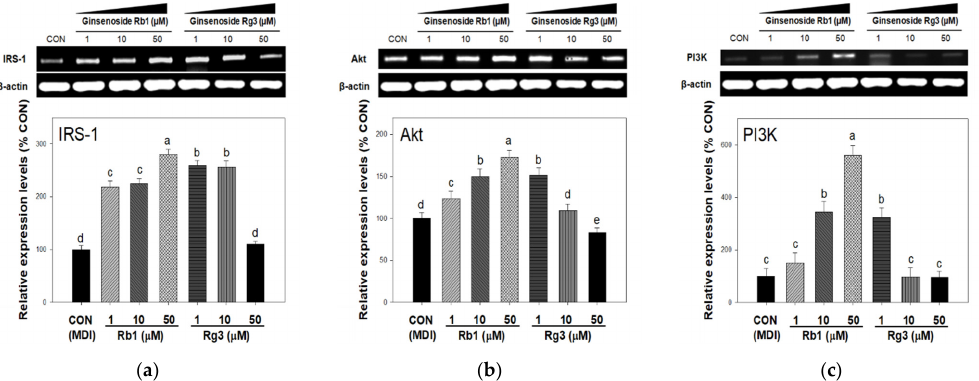
Figure 4. Changes of IRS-1, Akt, and PI3K mRNAs expression by ginsenoside Rb1 and Rg3 during the differentiation of 3T3-L1 preadipocytes. Values are the means ± SDs of four samples. a–e Bars with different letters indicate statistically significant differences among groups at p < 0.05.